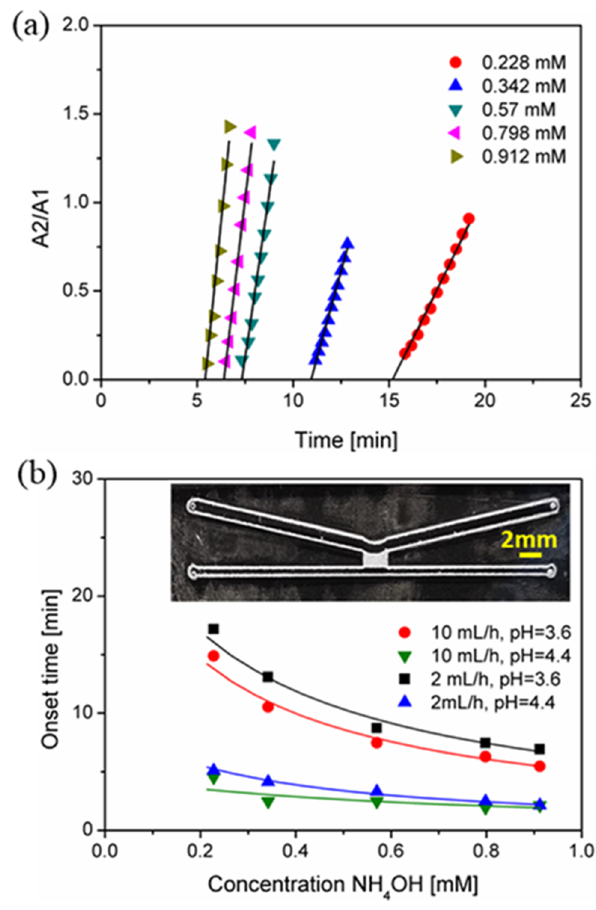
Figure 5. Concentration-dependent ammonia sensing on the chip: ( a ) linear fitting of the ratio of A2/A1 vs. experimental time for determination of onset time at flow rate of 10 mL/h at pH 3.6; and ( b ) onset time versus ammonium concentration at two different flow rates (2 and 10 mL/h in the sample channel) and two different pHs (3.6 and 4.4,